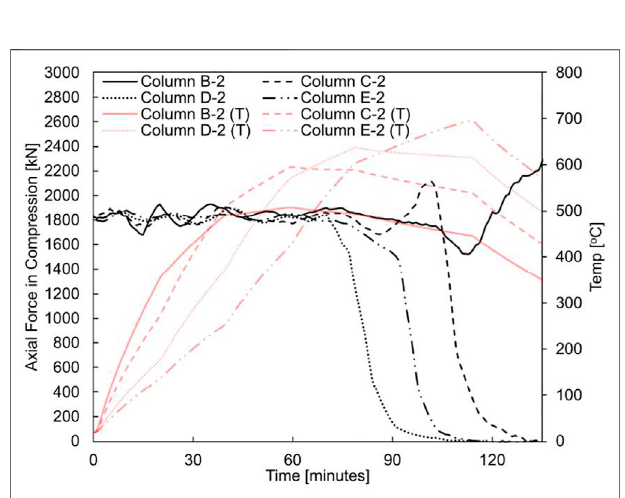
FIGURE 14 | (A) Column failure summary for Fire Scenario #3 and (B) the deformed shape of the structure at 150 min.